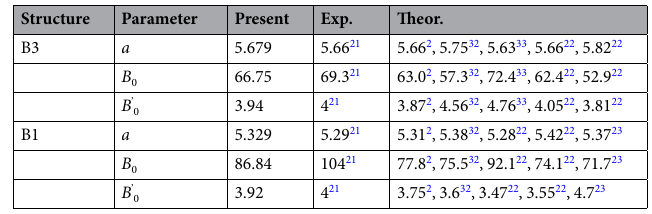
Table 1. The obtained lattice constant ( a ), bulk modulus B 0 , and the pressure derivative of bulk modulus ( B ’ 0 ) of ZnSe in both phases at T = 0 K, compared with the experimental result and some theoretical